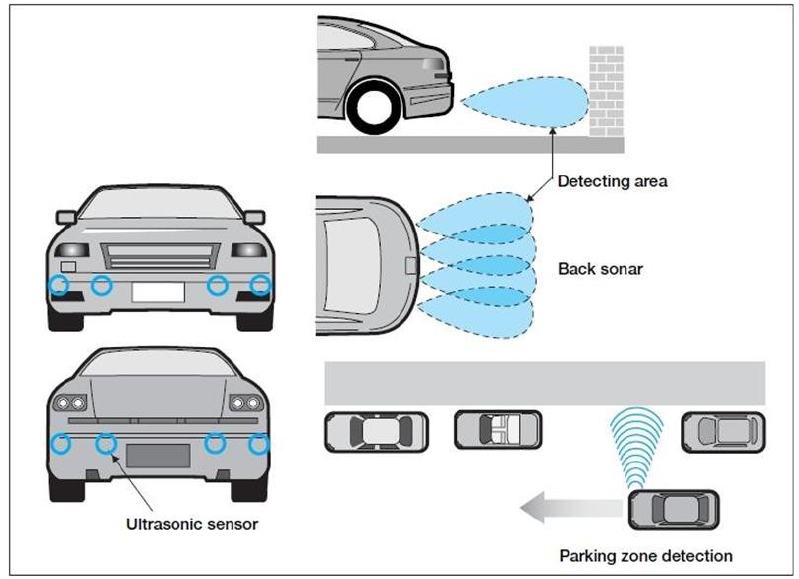
Figure 8. Applications of ultrasonic sensors in vehicles (Image source: